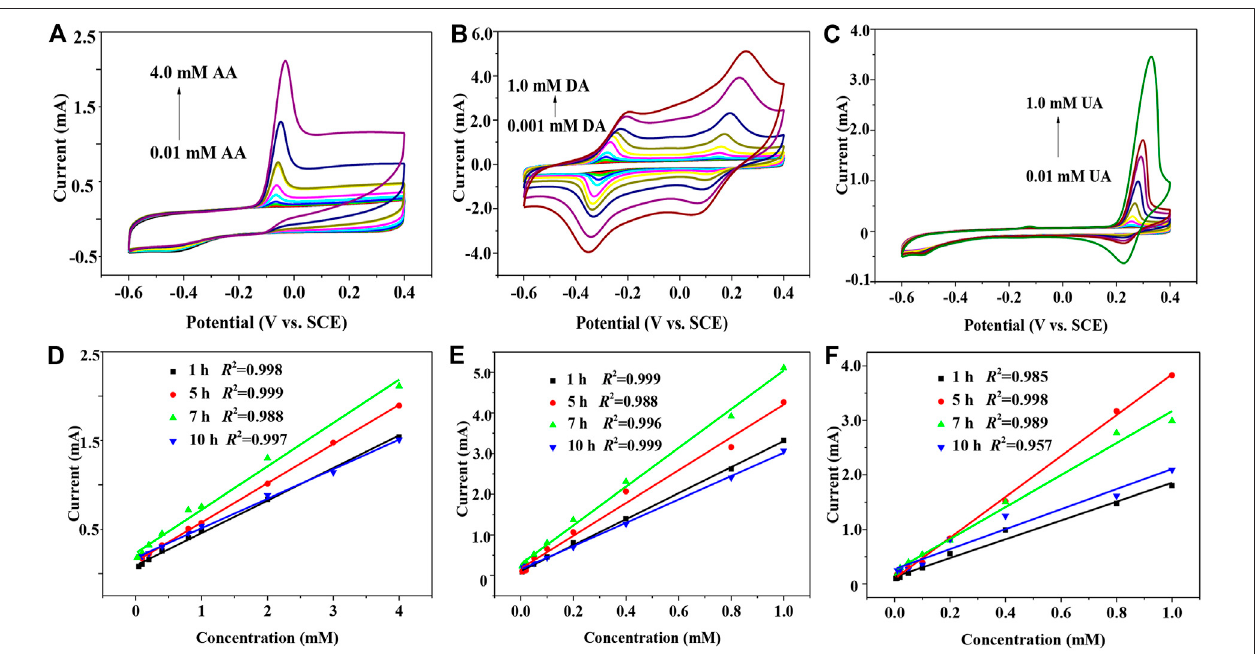
FIGURE 3 | GNSs/CC electrodes with different GN growth periods are used to separately detect AA, DA, and UA by CV. (A) CV detecting AA alone. (B) CV detecting DA alone. (C) CV detecting UA alone. (D) Fitting results of the relationship between the current and concentration are obtained by detecting AA using GNSs/ CC. (E) Fitting results of the relationship between the current and concentration are obtained by detecting DA using GNSs/CC. (F) Fitting results of the relationship between the current and concentration are obtained by detecting UA using